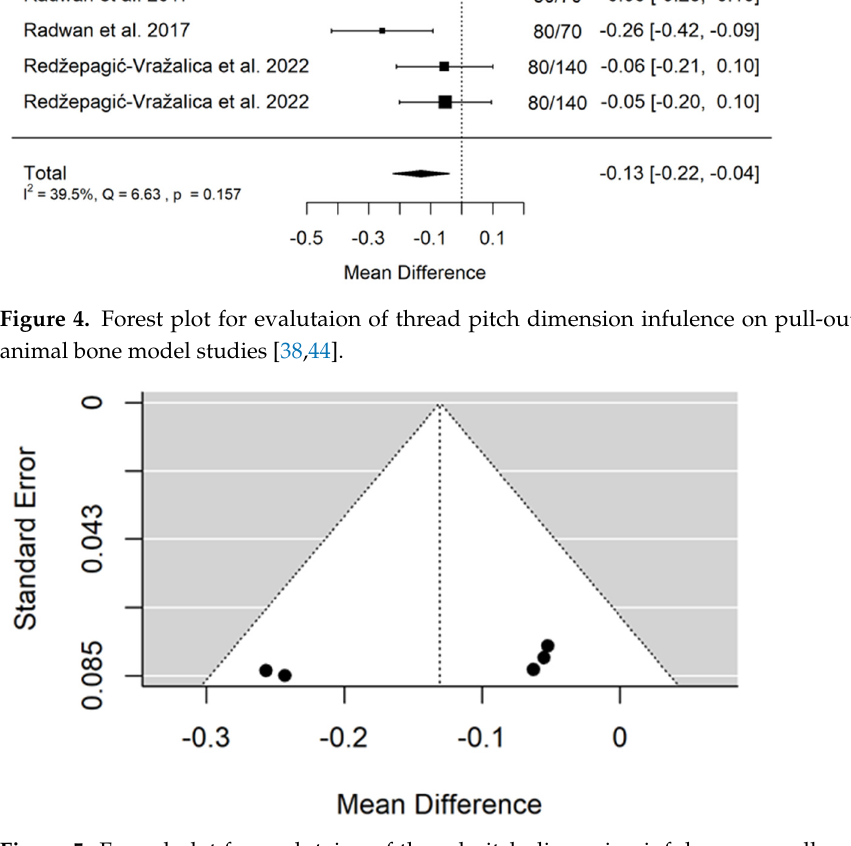
Figure 5. Funnel plot for evalutaion of thread pitch dimension infulence on pull-out strentght in animal bone model